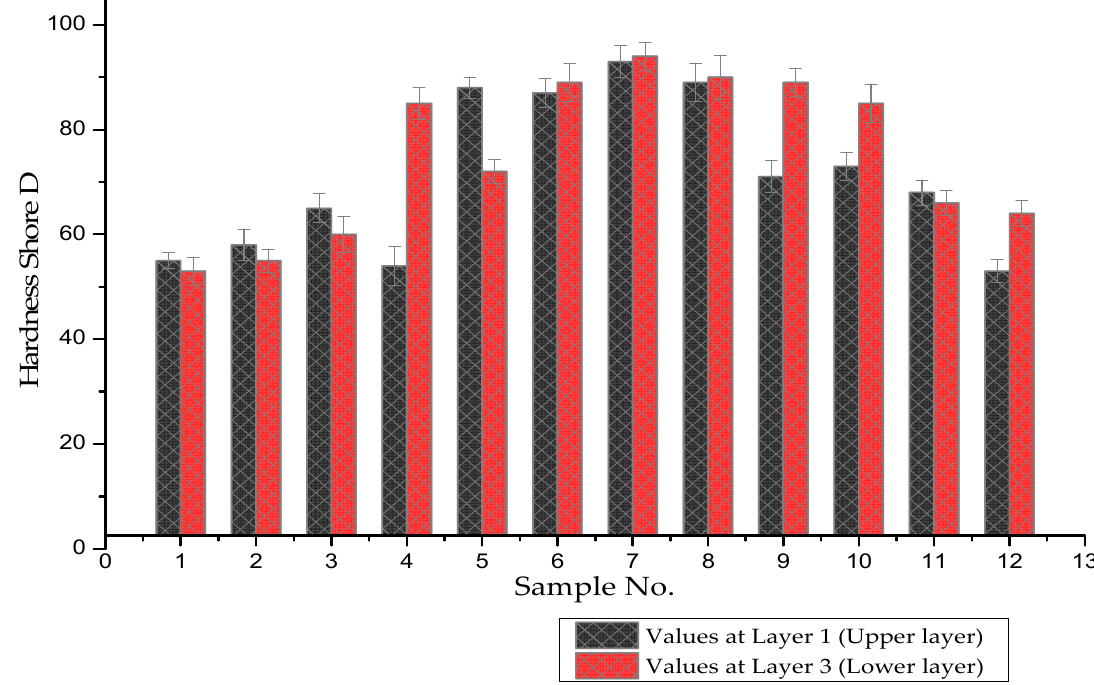
Figure 9. Barcol hardness as a function of wt% and location of SiC particles.